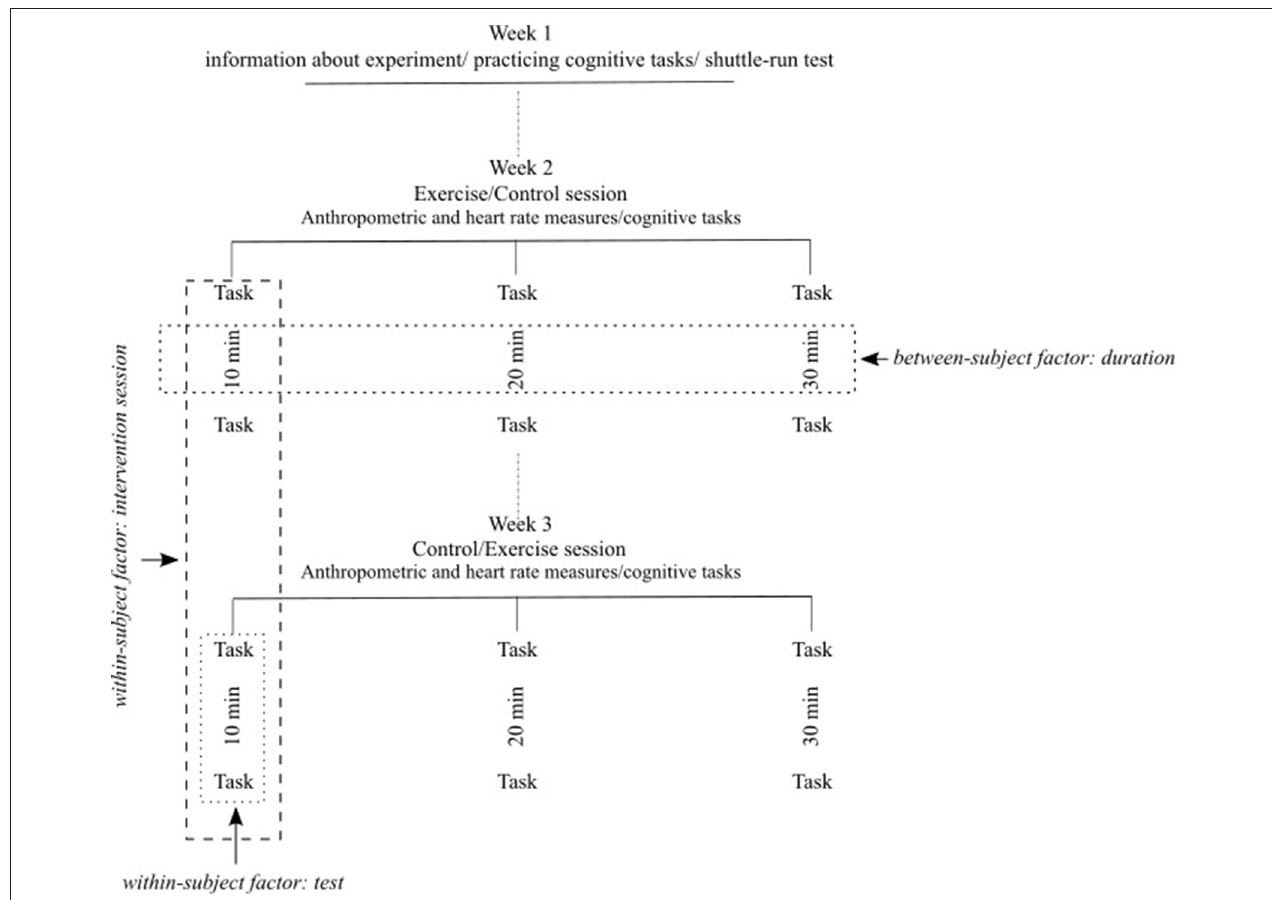
FIGURE 1 | Schematic representation of the experimental design.